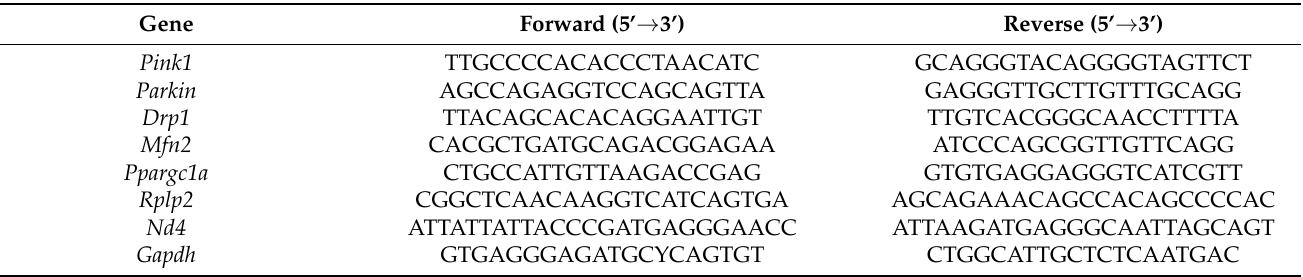
Table 3. List of gene-specific primers for RT-PCR analysis.